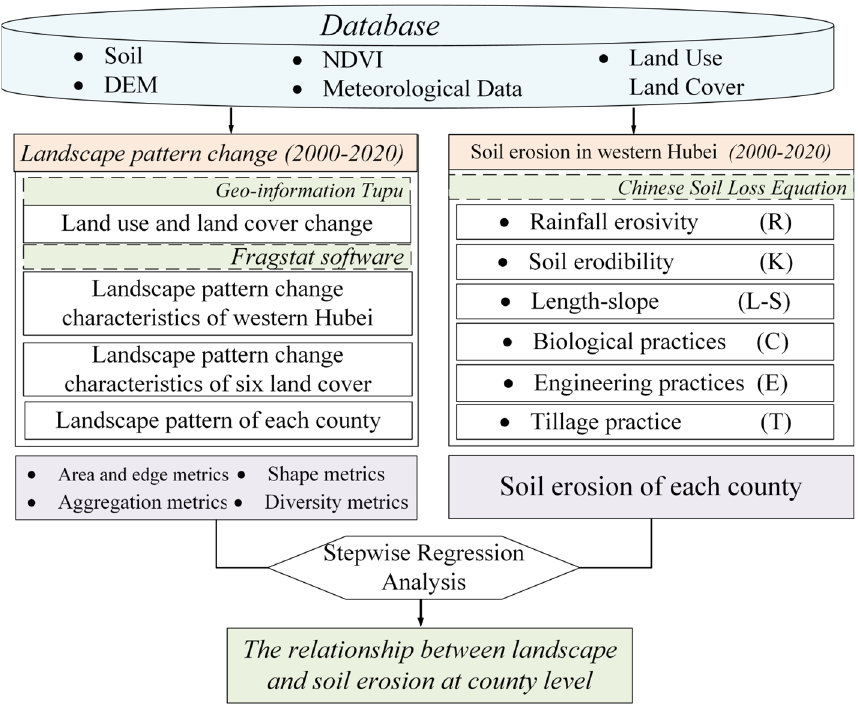
Figure 1. Framework of this study.